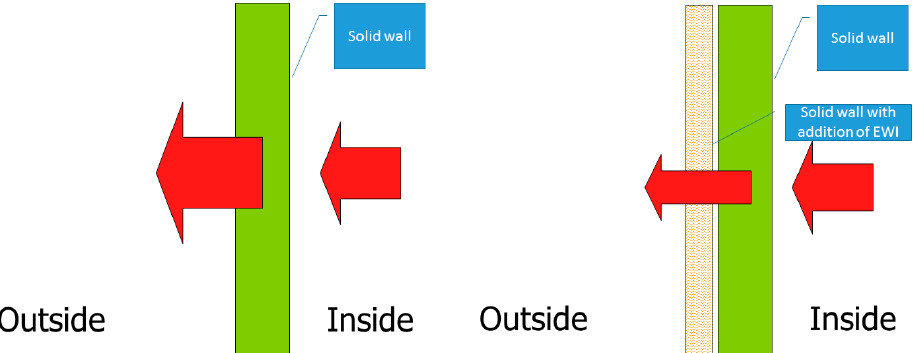
Figure 2. Illustration of heat loss from a building: inside to outside, before and after EWI